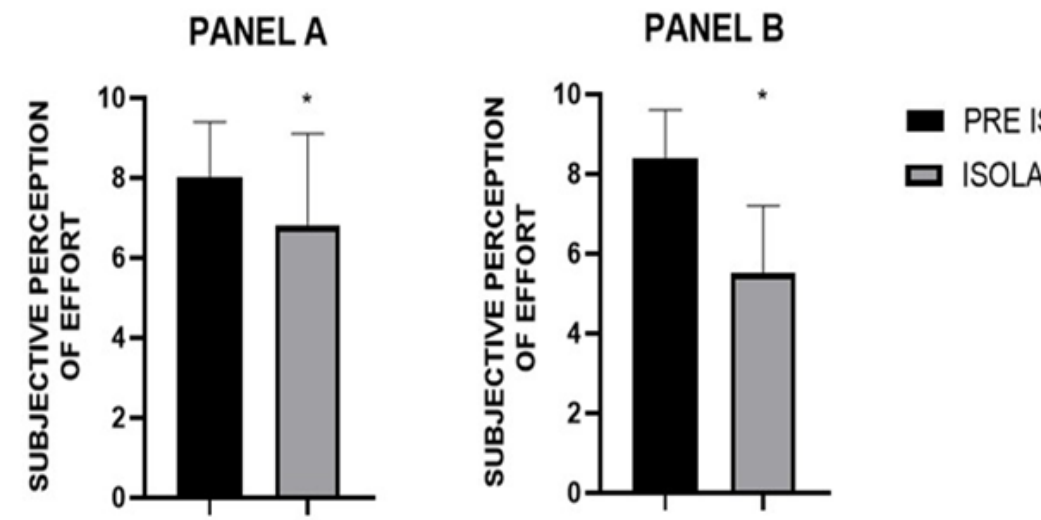
Figure 1. Subjective Perception of Effort (SPE). Data are presented as mean and standard deviation of the mean. *Statistical difference between pre-isolation and isolation moments. Panel a) general data; Panel b) data only from athletes who reduced training